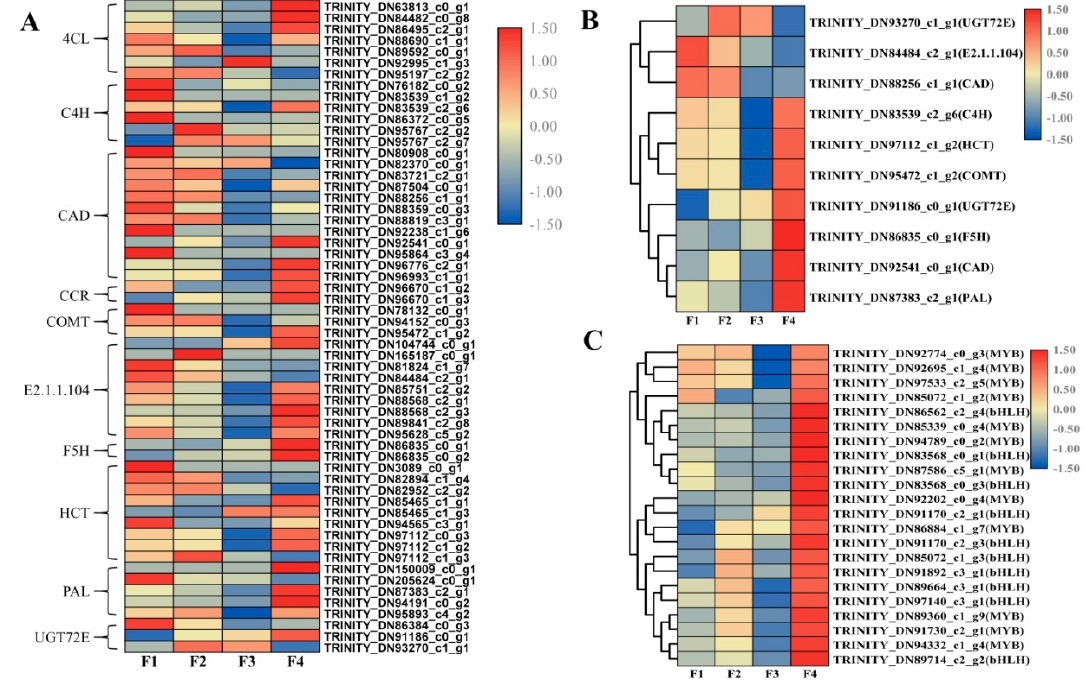
Figure 2. The heat map of phenolic acid biosynthesis pathway genes ( A ), the differential gene expression in phenolic acid biosynthesis pathway ( B ) and the heat map of MYB and bHLH transcription factors genes ( C ).